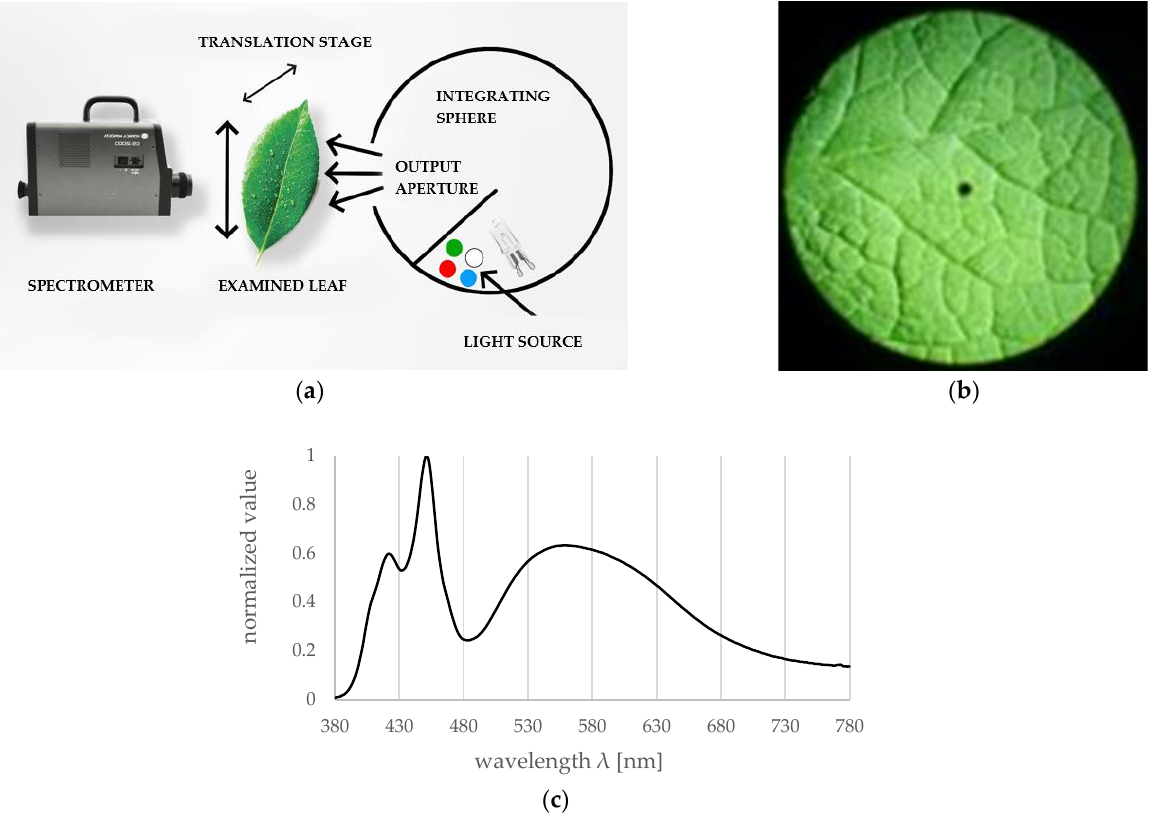
Figure 1. ( a ) Block diagram of the measurement setup. ( b ) View of the tested leaf through the instrument viewfinder; small black dot represents the measurement field. ( c ) Spectrum of the developed illumination source, normalized to its highest intensity.